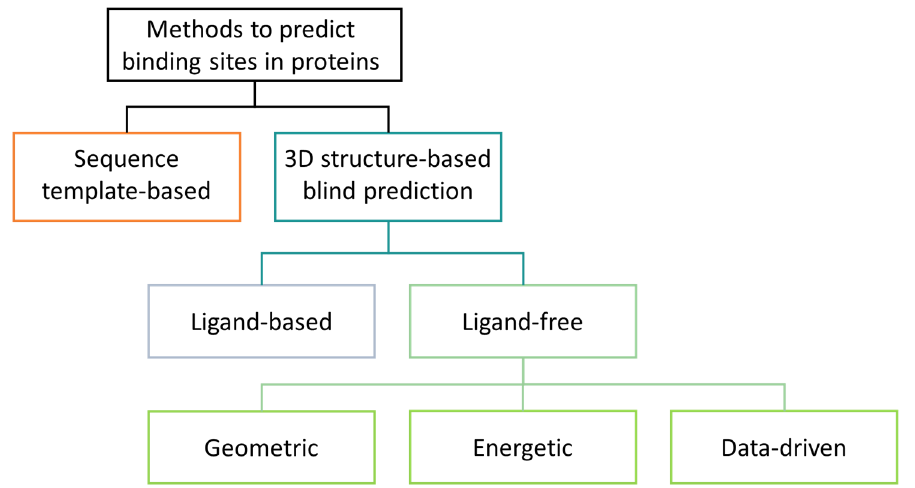
Figure 1. Classification of binding site detection methods.